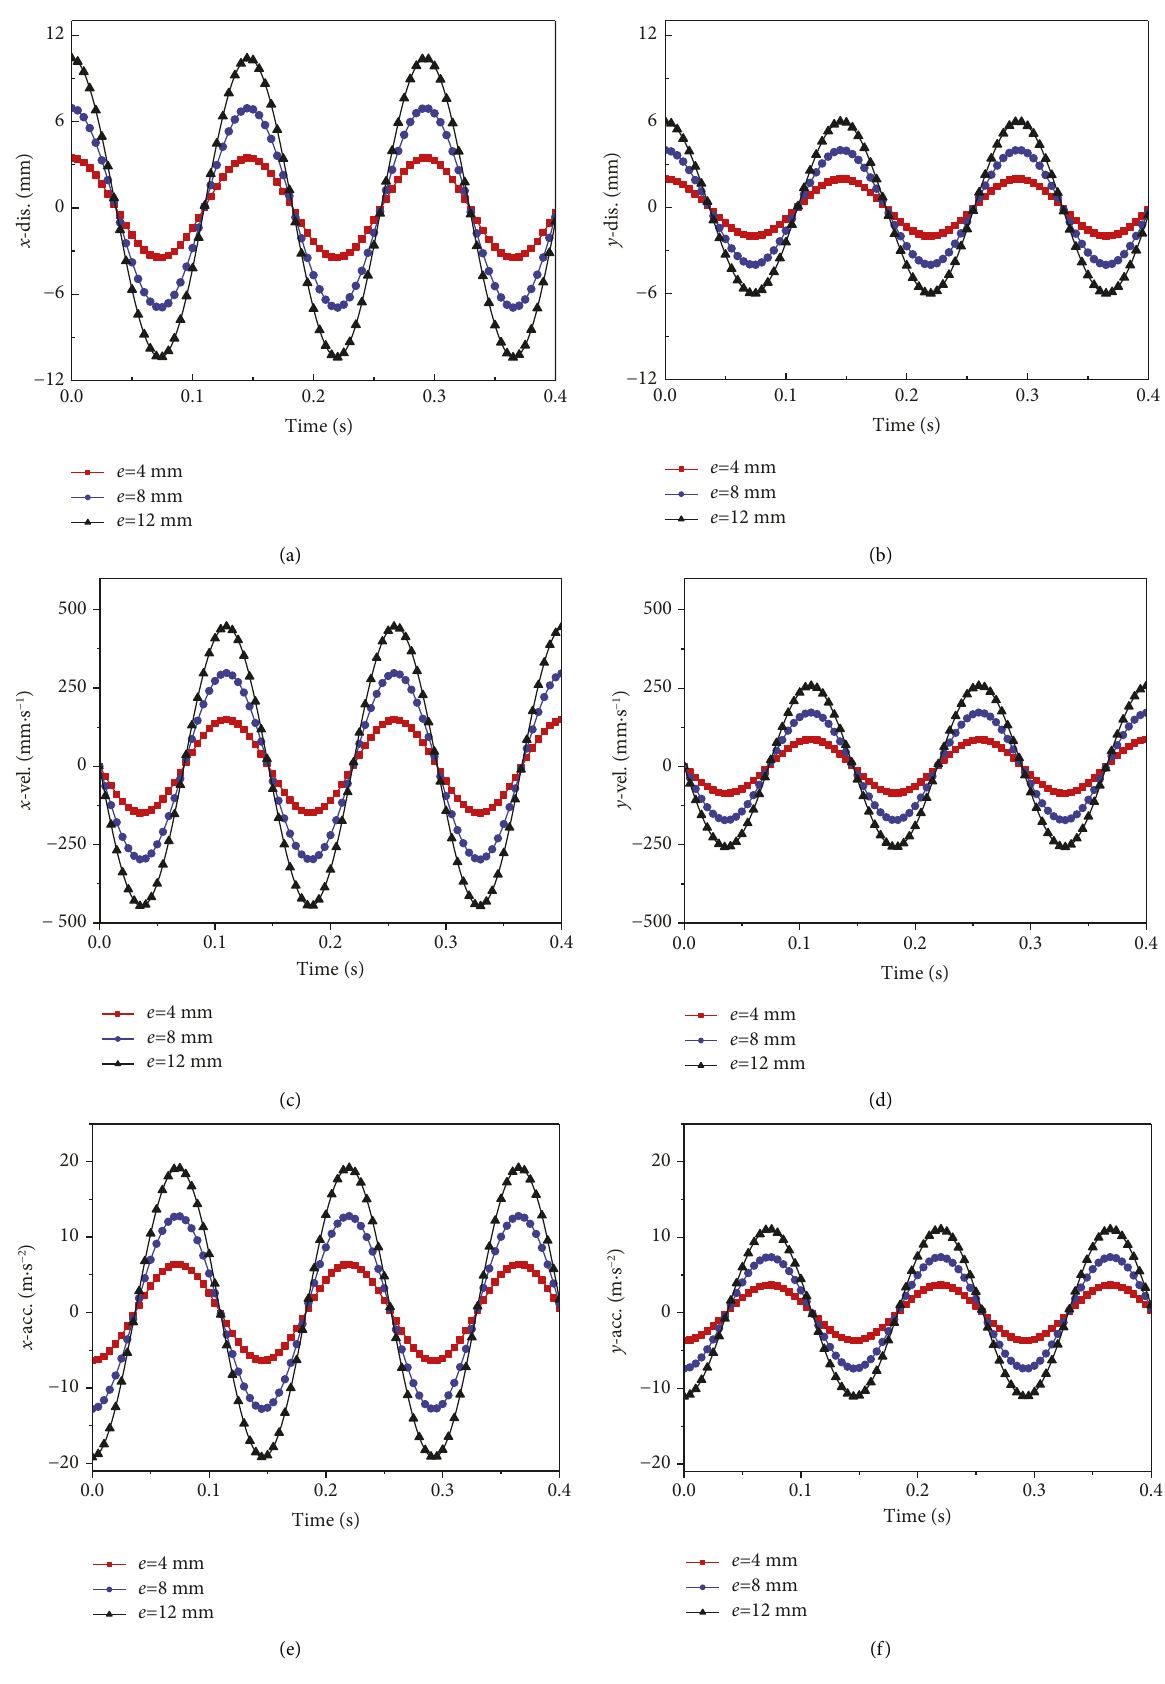
Figure 10: Kinematic characteristics of the NCDS with different eccentricity e (a), (b) displacement (x) y; (c), (d) velocity _ x , _ y ; and (e), (f) acceleration € x , € y